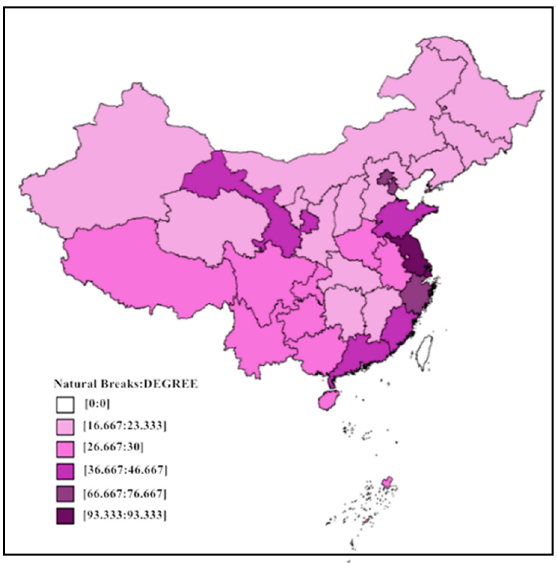
Figure 2. The degree centrality of the health economic spatial network.